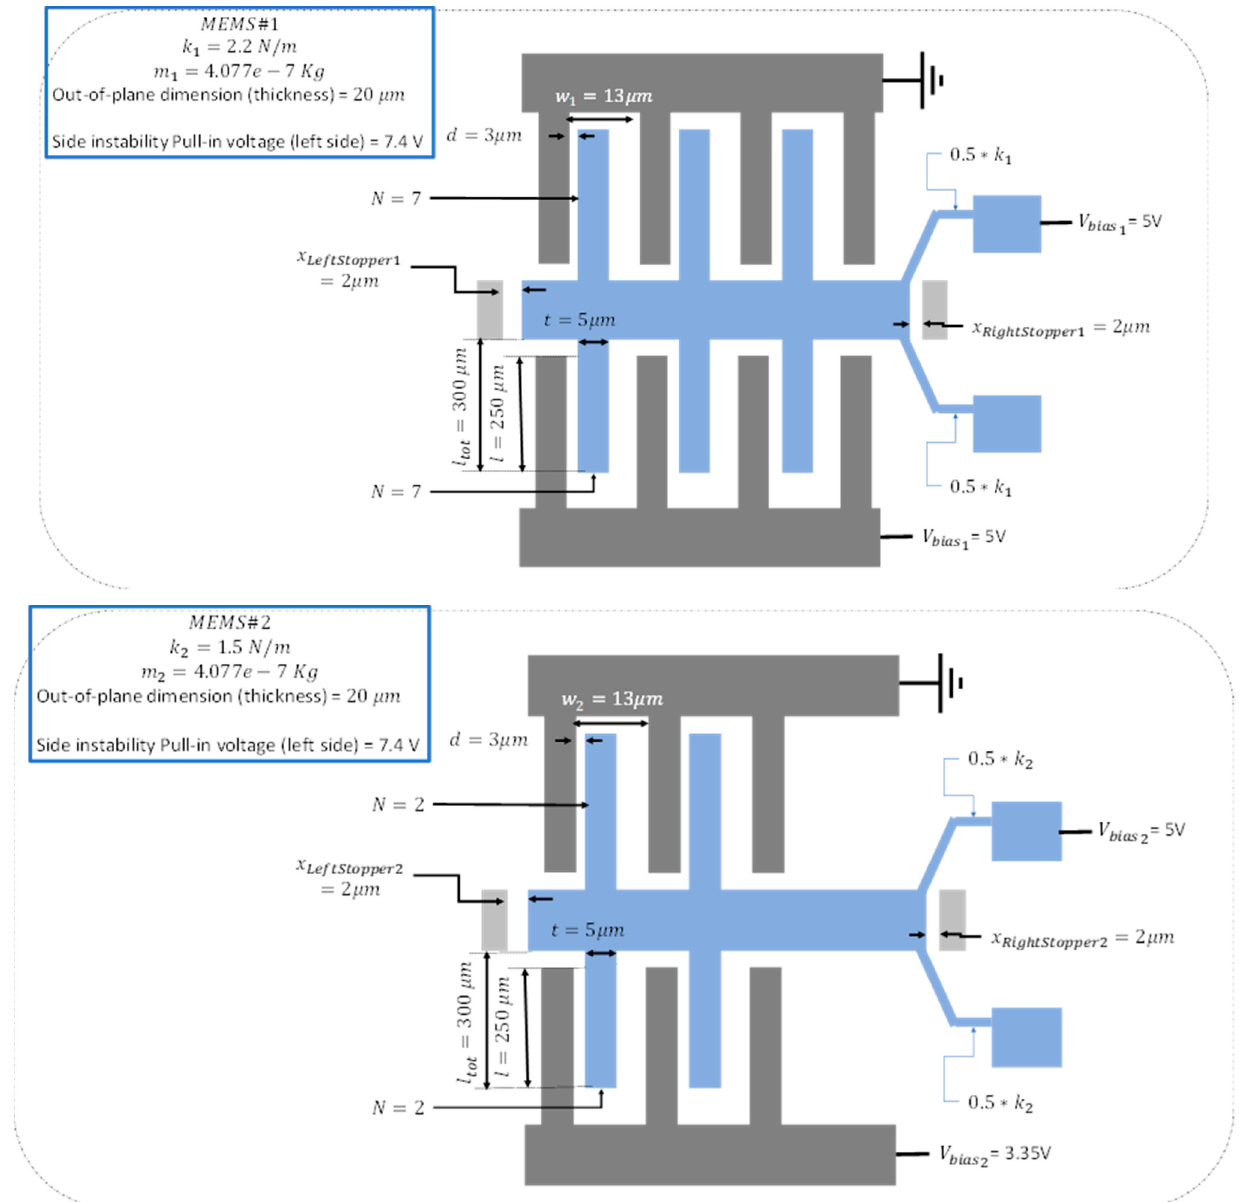
Figure A2. Design of the input layer MMES device (labeled MEMS1 and MEMS2 in Section 4), including information about the total stiffness of the MEMS devices and the pull-in voltages. Top figure: MEMS1, bottom figure: MEMS2.